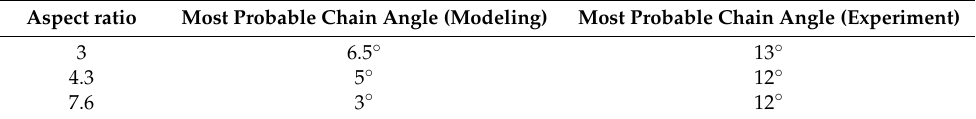
Table 4. Most probable chain angle from modeling and experimental results.